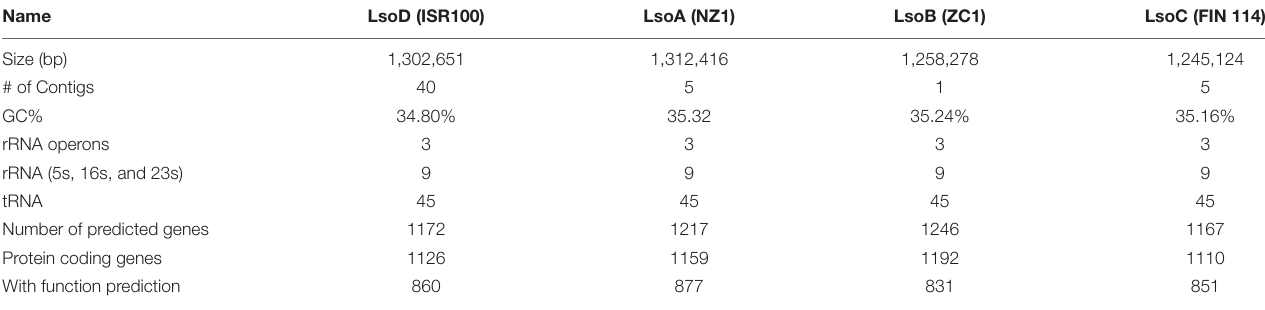
TABLE 2 | Features of Candidatus Liberibacter solanacearum